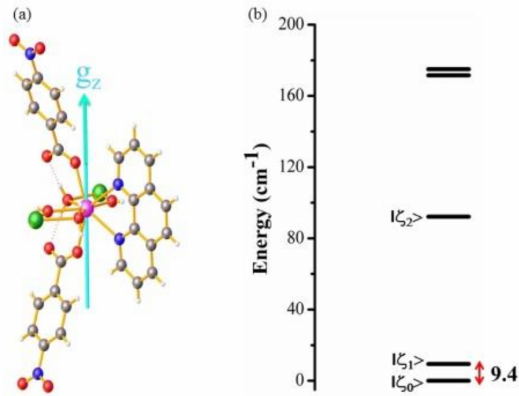
Figure 8. ( a ) Ab initio computed orientation of the principal magnetization axis of the ground state ( b ) CF split energy levels calculated by ab initio for Tb(III) centre in complex 1